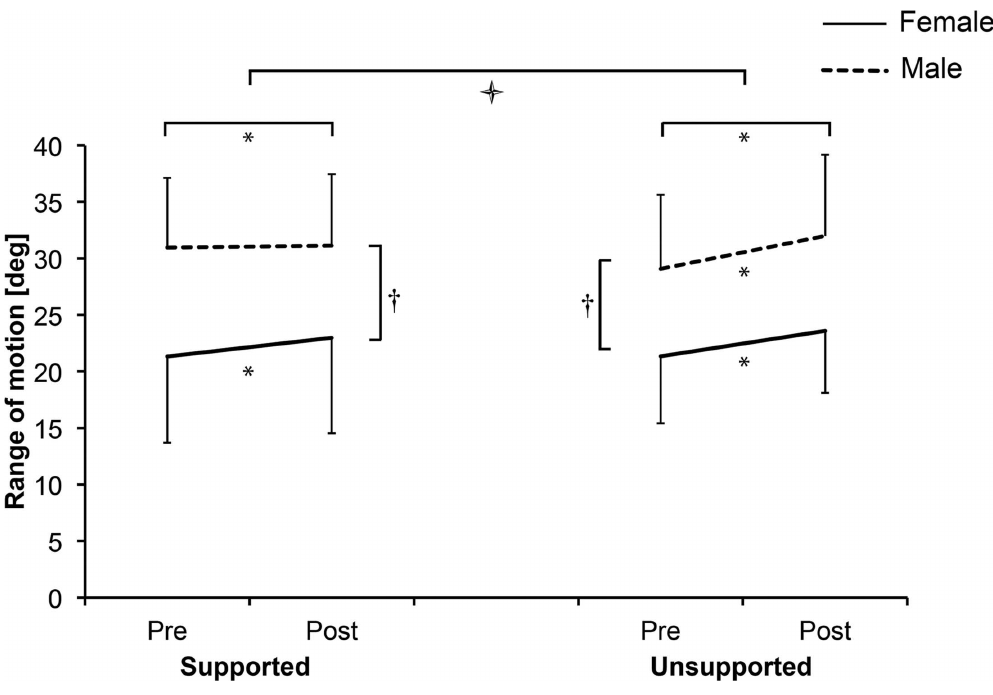
effect (p < .05); - Interaction effect (p < .05).